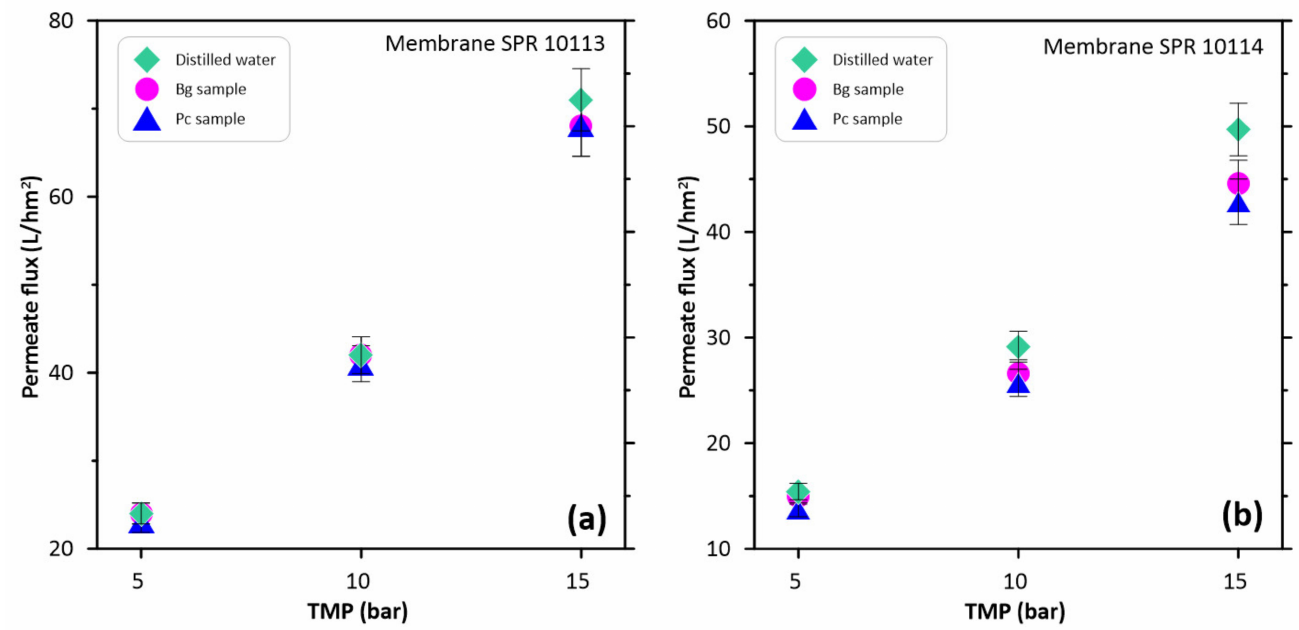
Figure 4. Volumetric permeate flux as a function of the applied trans-membrane pressure for ( a ) the SPR 10113 membrane and ( b ) the SPR 101014 membrane.